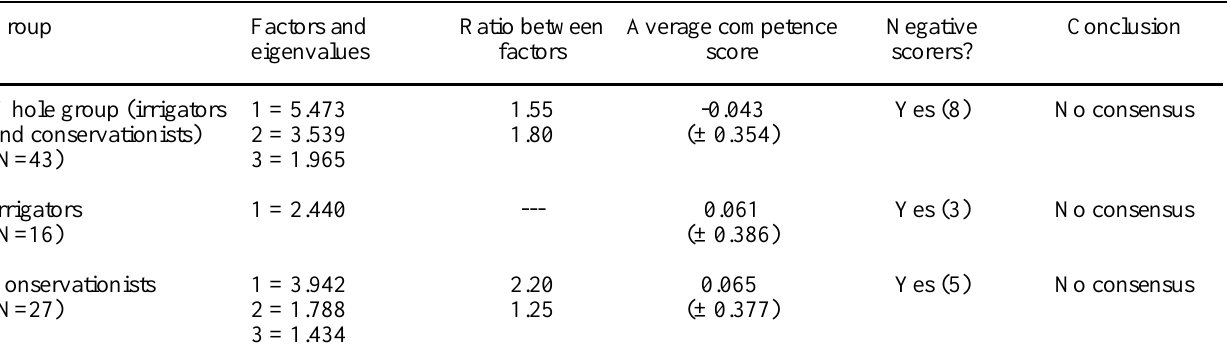
Table 8 . Results of the consensus analysis of the pile sort for “priorities for future water use in the Crocodile River not flowing?” (37 items). Group Factors and